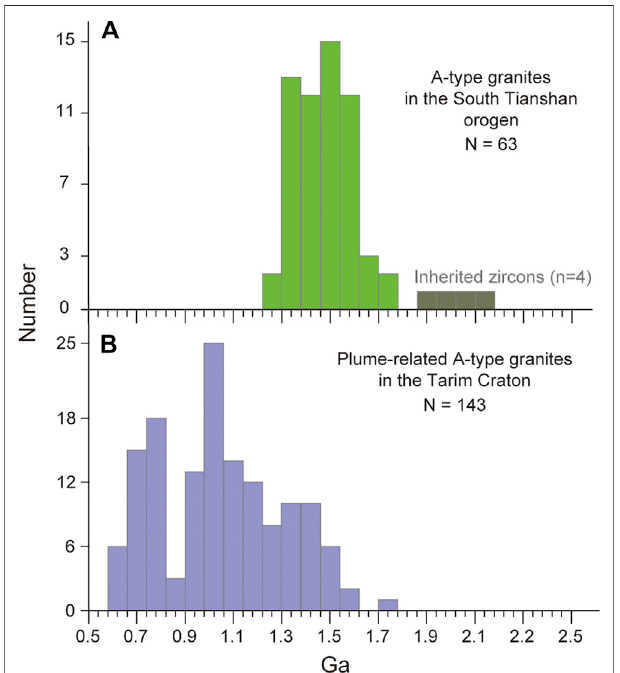
FIGURE6| Histogramsofcorresponding T DM2 modelages. (A) Permian A-types granitoids in the South Tianshan (see Supplementary Table S3 for data sources) have older T DM2 model ages concentrated at 1.3 – 1.7 Ga (older than 2.0 Ga for inherited zircons), compared with (B) the plume-related Permian A-type granitoids in the Tarim Craton (data sources can be found in Suetal.,2019;Weiet al.,2019;Zhangetal.,2010),whichhaveyounger T DM2 model ages mostly ranging from 540 Ma to 1,500 Ma.